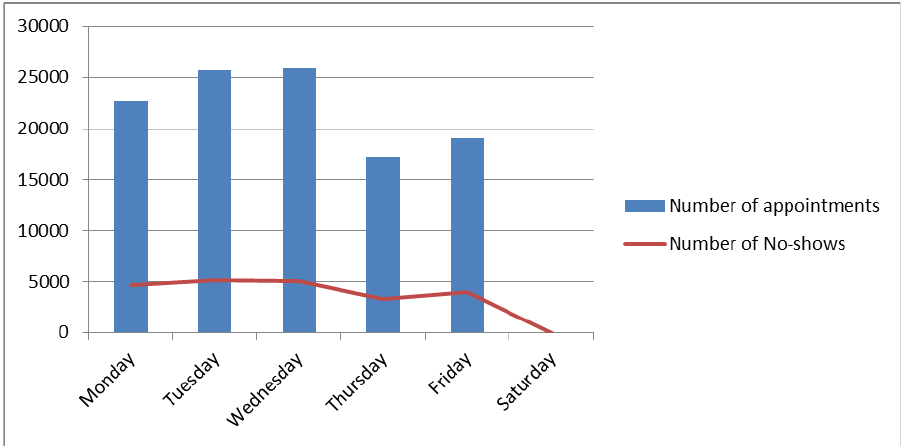
Figure 2. Distribution of no-show based on appointment week